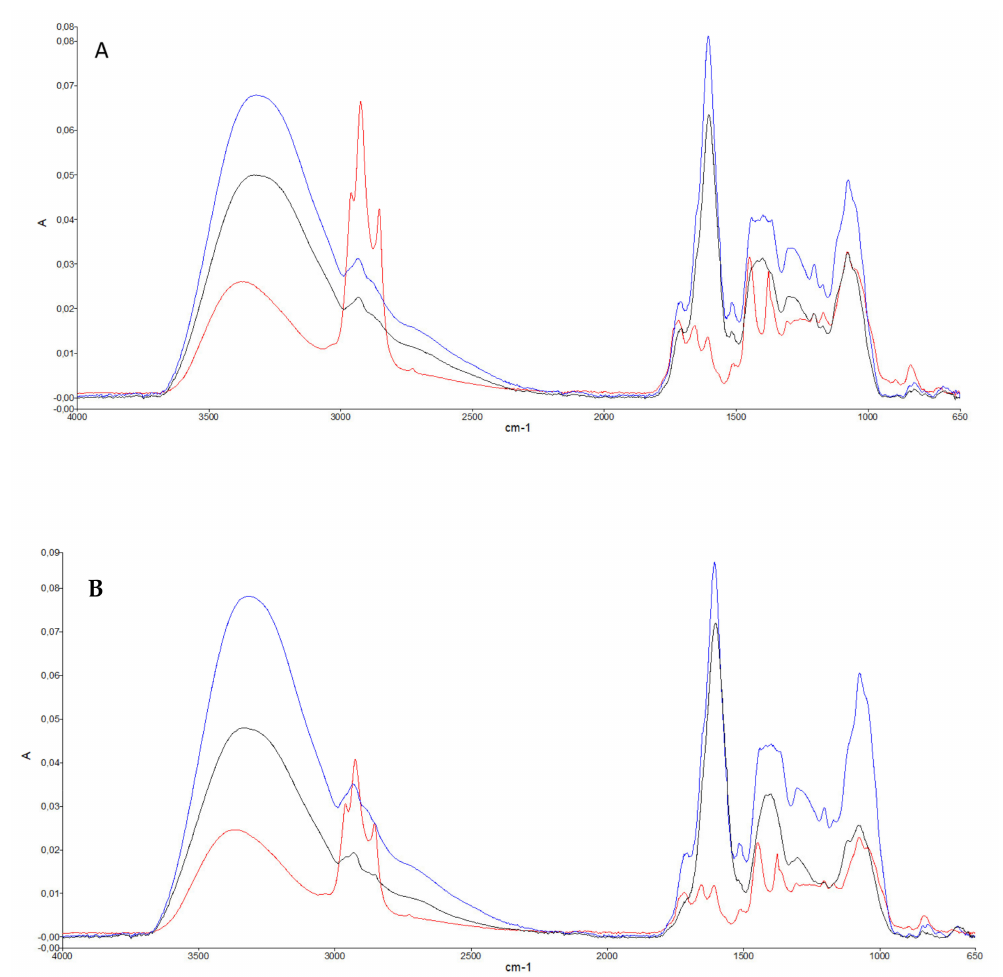
Figure 1. FTIR absorption spectrum ‘Aglianico’ ( A ) and ‘Greco di Tufo’ ( B ) leaf extract with EtOH (red line), MetOH:H 2 O (70:30) (black line), H 2 O (blue line). The measured absorbance spectrum reported was baseline corrected. Peaks are identified by numbers. The wavelength of the peak absorbance is indicated in Table 4. Table 4. Vibrational mode of ‘Aglianico’ and ‘Greco di Tufo’ leaf extract spectra based on current literature. Range values of the peaks for ‘Aglianico’ and ‘Greco di Tufo’ harvested in October and November are reported. Spectral Ranges Analyzed with